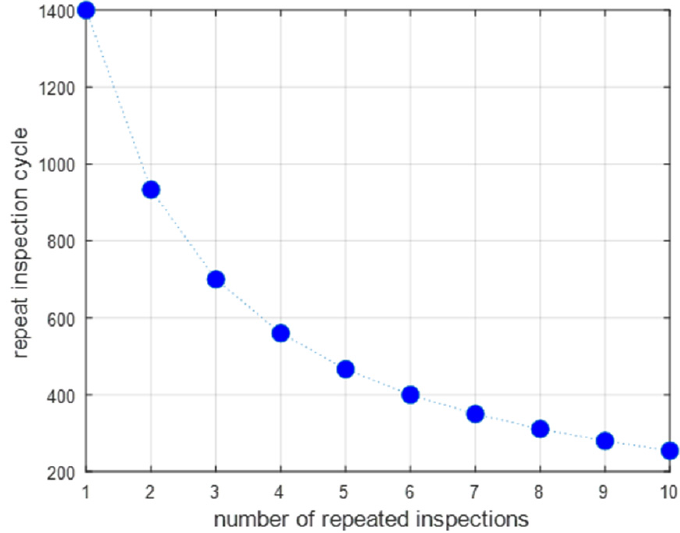
Figure 15. Number of repeated inspections with respect to the number of inspection